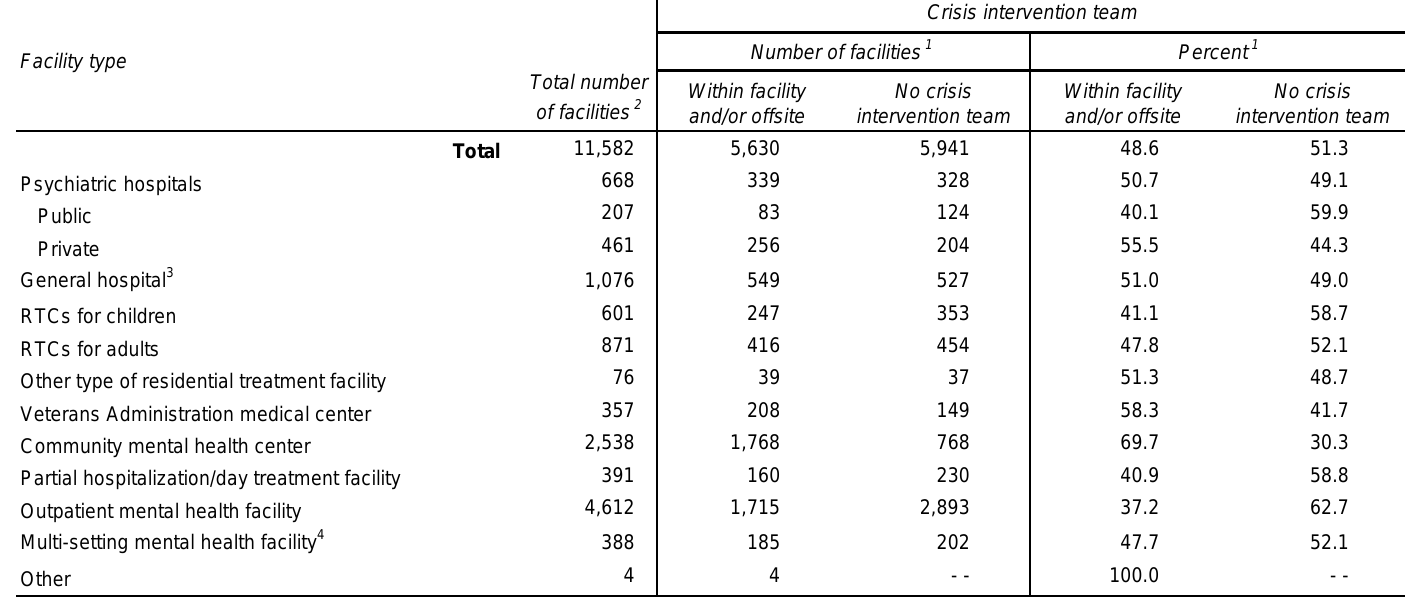
1 Of the 11,582 facilities that were given the standard questionnaire, 11 facilities (0.09 percent) did not respond to the question about having a